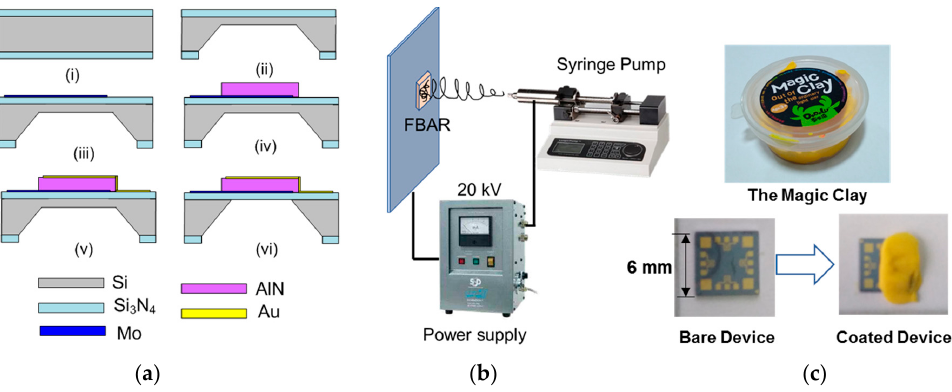
Figure 2. ( a ) Fabrication process of the FBAR formaldehyde sensor: (i) Growth of Si3N4 film; (ii) Etching of one side of the silicon wafer; (iii) Deposition and pattern of bottom Mo electrode; (iv) Deposition of AlN film; (v) Preparation of top Au electrode; (vi) Dry etching of the residual silicon. ( b ) Schematic diagram illustrating the electrospinning deposition of PEI nanofibers. ( c ) Photographs of the FBAR devices before and after the coating of clay.